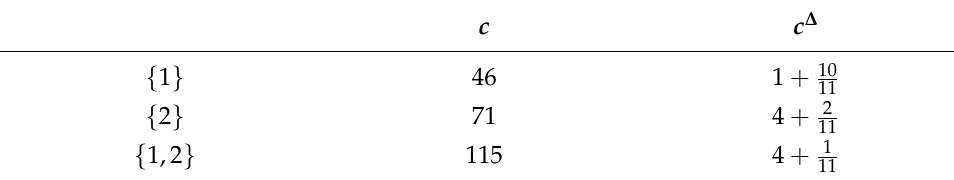
Table 13. The surplus